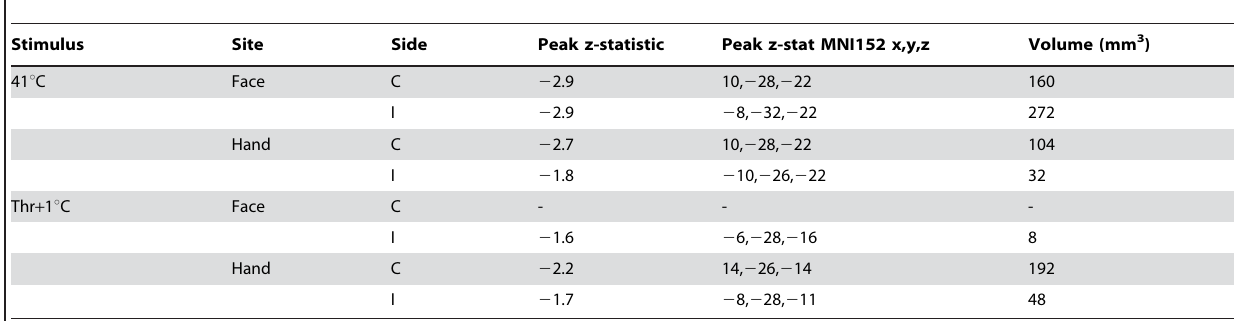
C=Contralateral to affected side. I=Ipsilateral to affected